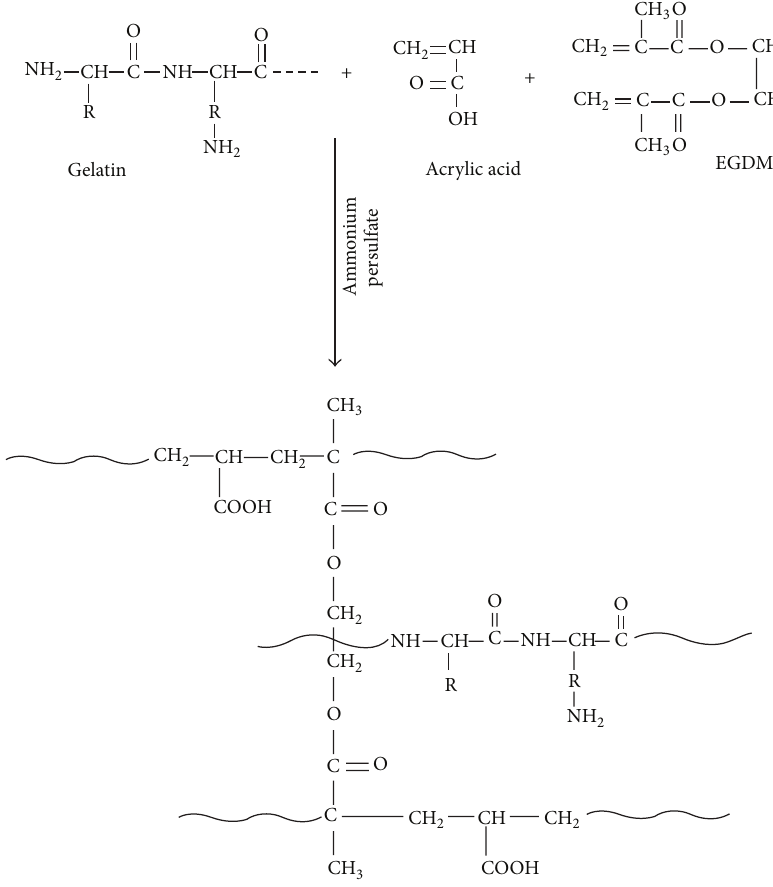
Figure 2: Presumptive structure of EGDMA cross-linked interpenetrating networks of AA/Gelatin